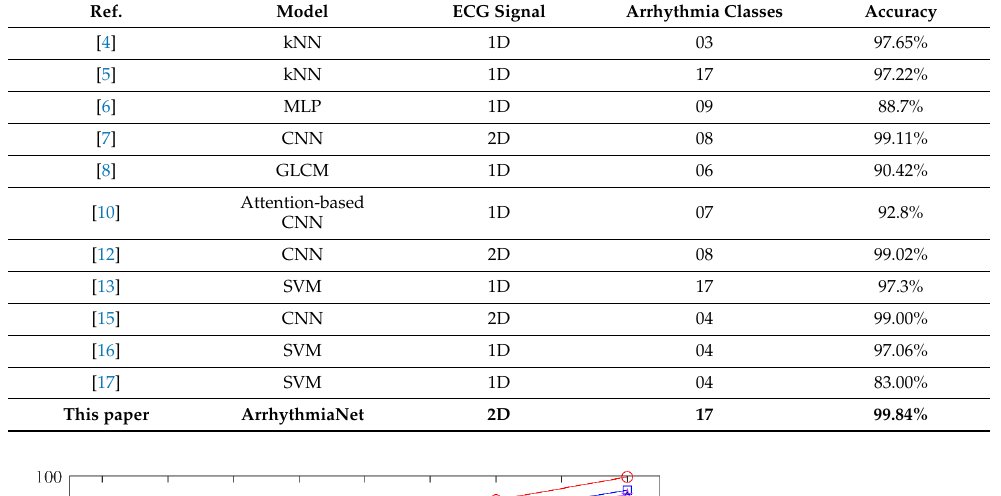
Table 4. Comparison of the performance of ArrhythmiaNet with the state-of-the-art techniques. Ref.